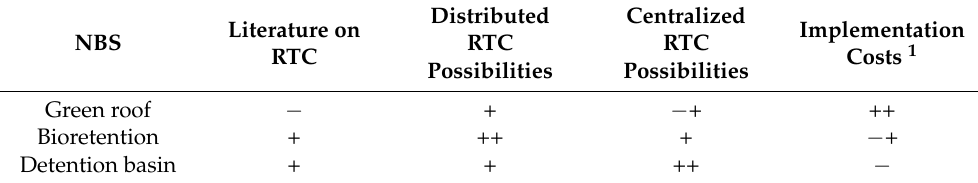
Table 2. Comparative analysis on discussed NBS to RTC